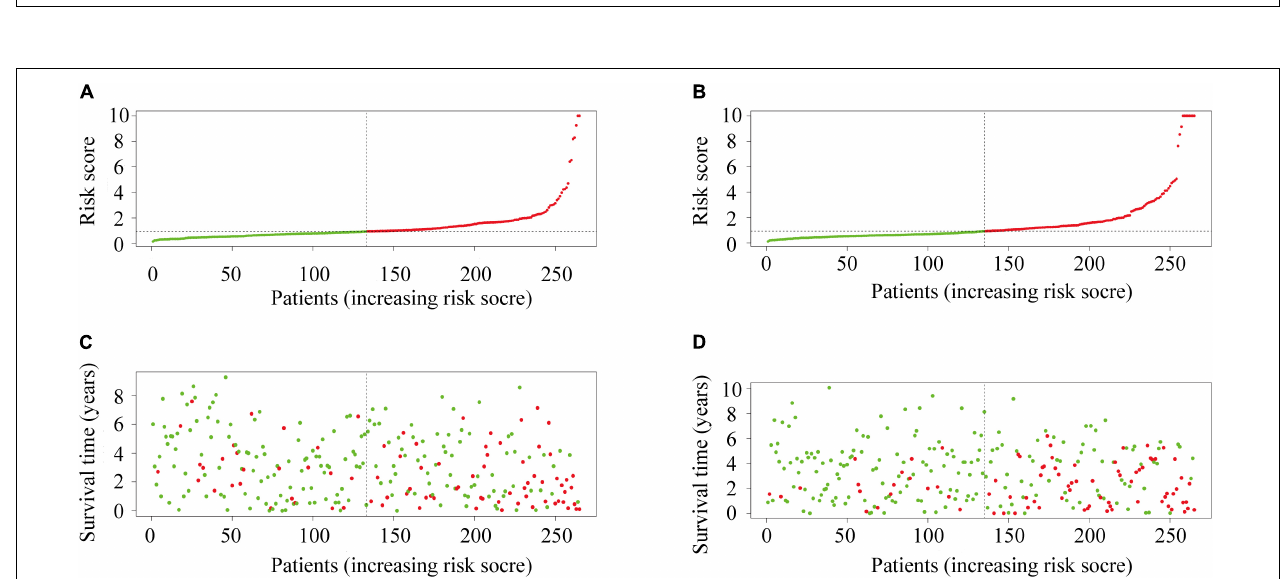
FIGURE 4 | (A) The distribution of risk scores in the training group. (B) The distribution of risk score in the test group. (C) Survival plots of patients in the training group. (D) Survival plots of patients in the test group.